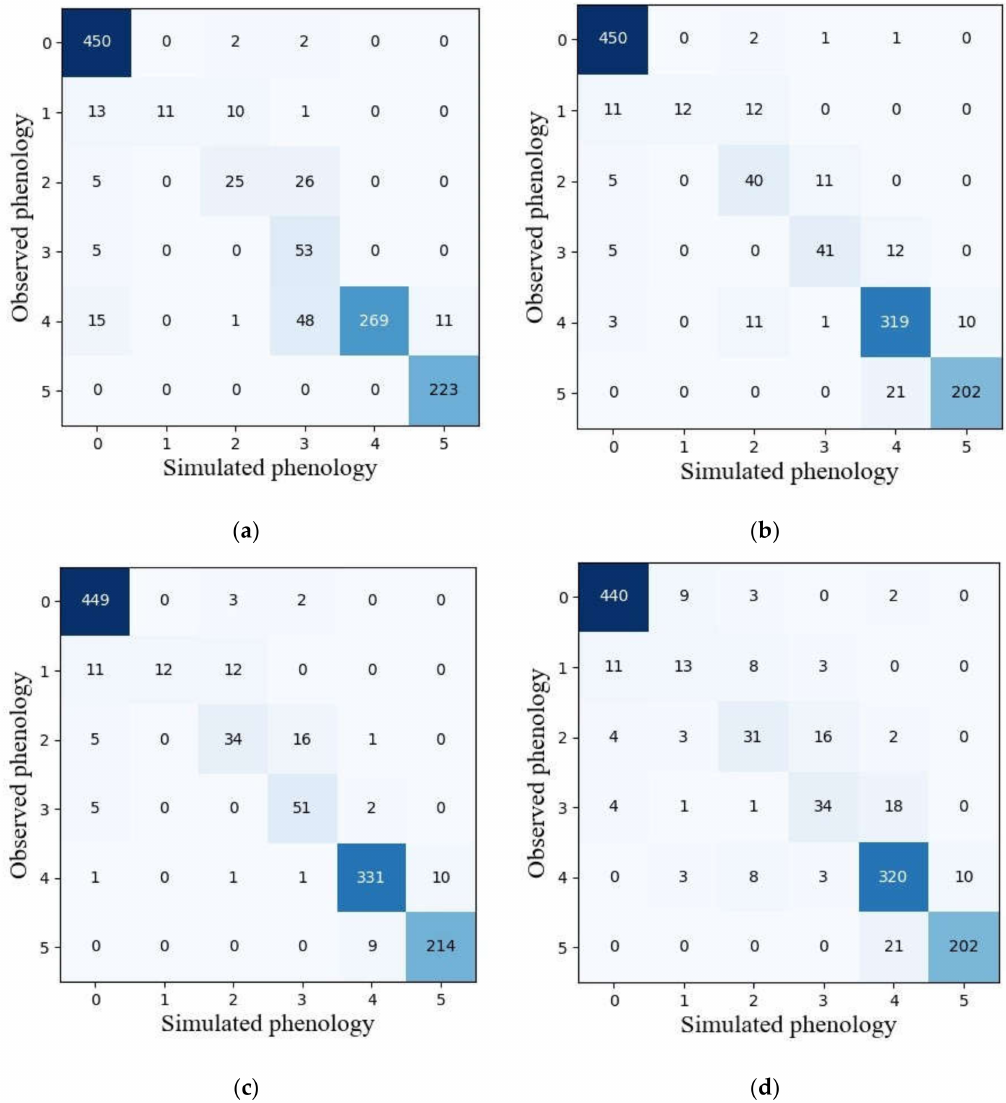
Figure 7. The confusion matrixes of simulated and observed phenology achieved by GNB ( a ), hard voting ( b ), soft voting ( c ) and model stacking ( d ) using the validation dataset. Note: 0–5 represent vegetative, initial heading, heading, full heading, ripening and maturity stages,